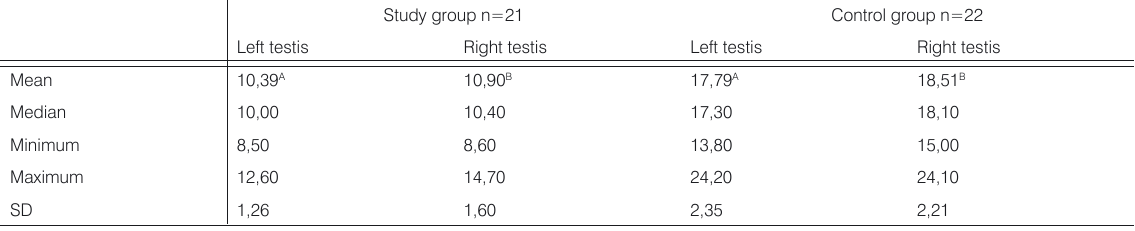
Table 2. Study and control groups-statistical analysis of testes’ volumes